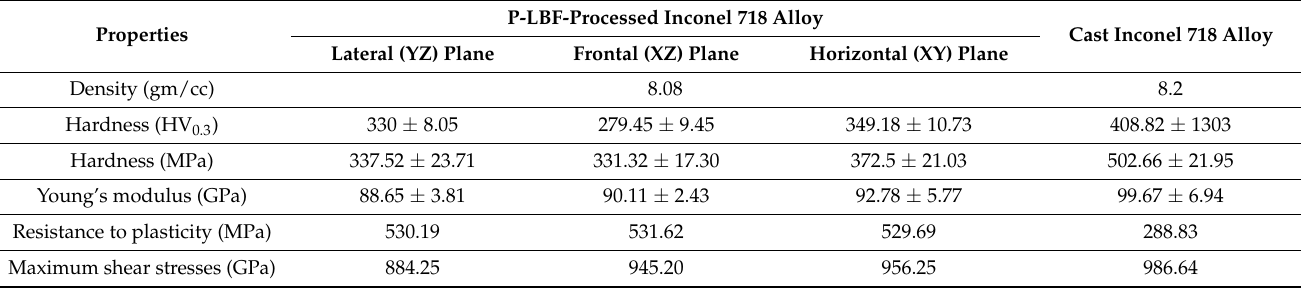
Table 1. Physical and mechanical properties of the currently investigated Inconel 718 alloy fabricated by L-PBF and casting